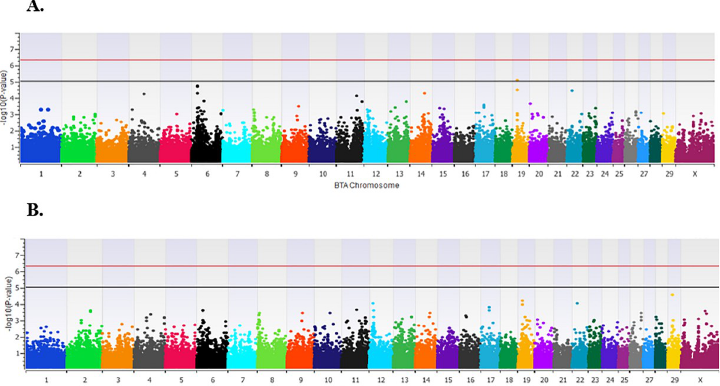
Fig 1. Manhattan plots of loci associated with fertility in a genome-wide association analysis using an approach similar to EIGENSTRAT. Panel A identified the locus associated with the number of services required to successfully conceive and maintain pregnancy (TBRD), and heifer conception rate at first service (HCR1) was identified in Panel B. SNP located between the black and red lines provide evidence of a moderate association ( P < 1 × 10 − 5 ) with